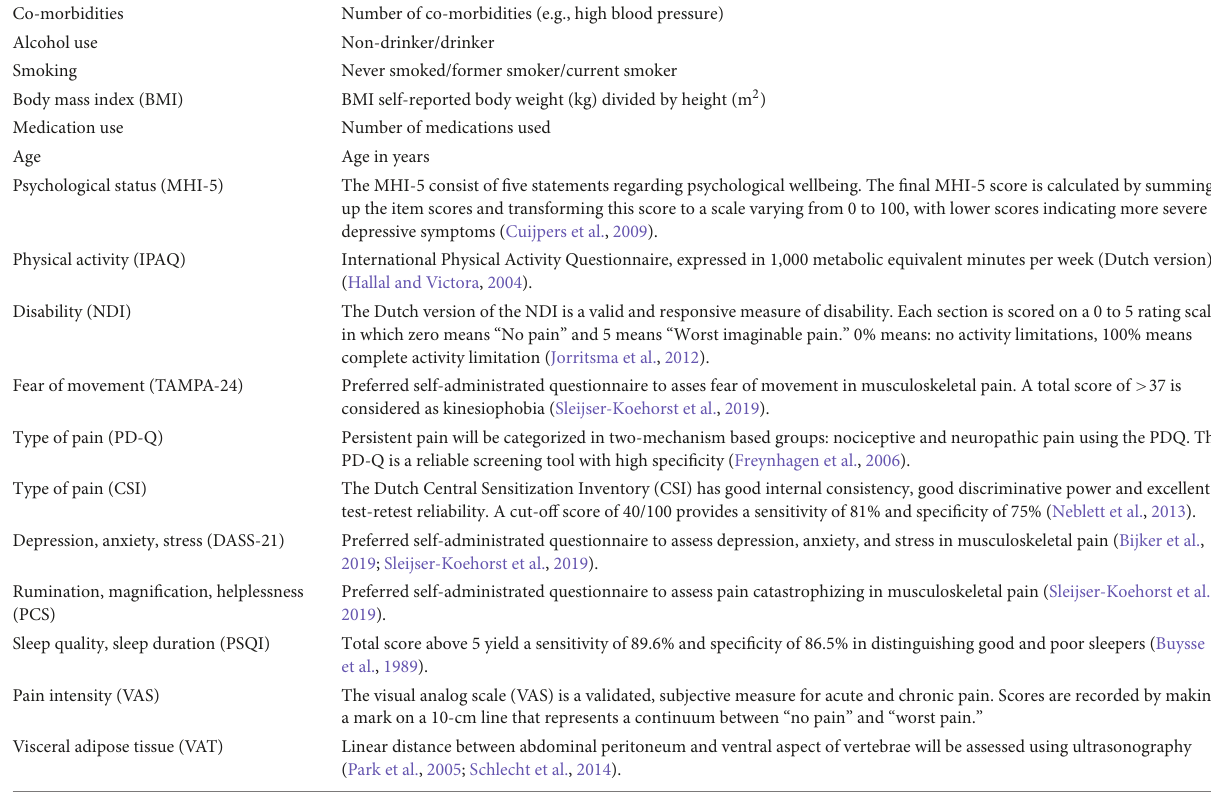
TABLE 2 Questionnaires and